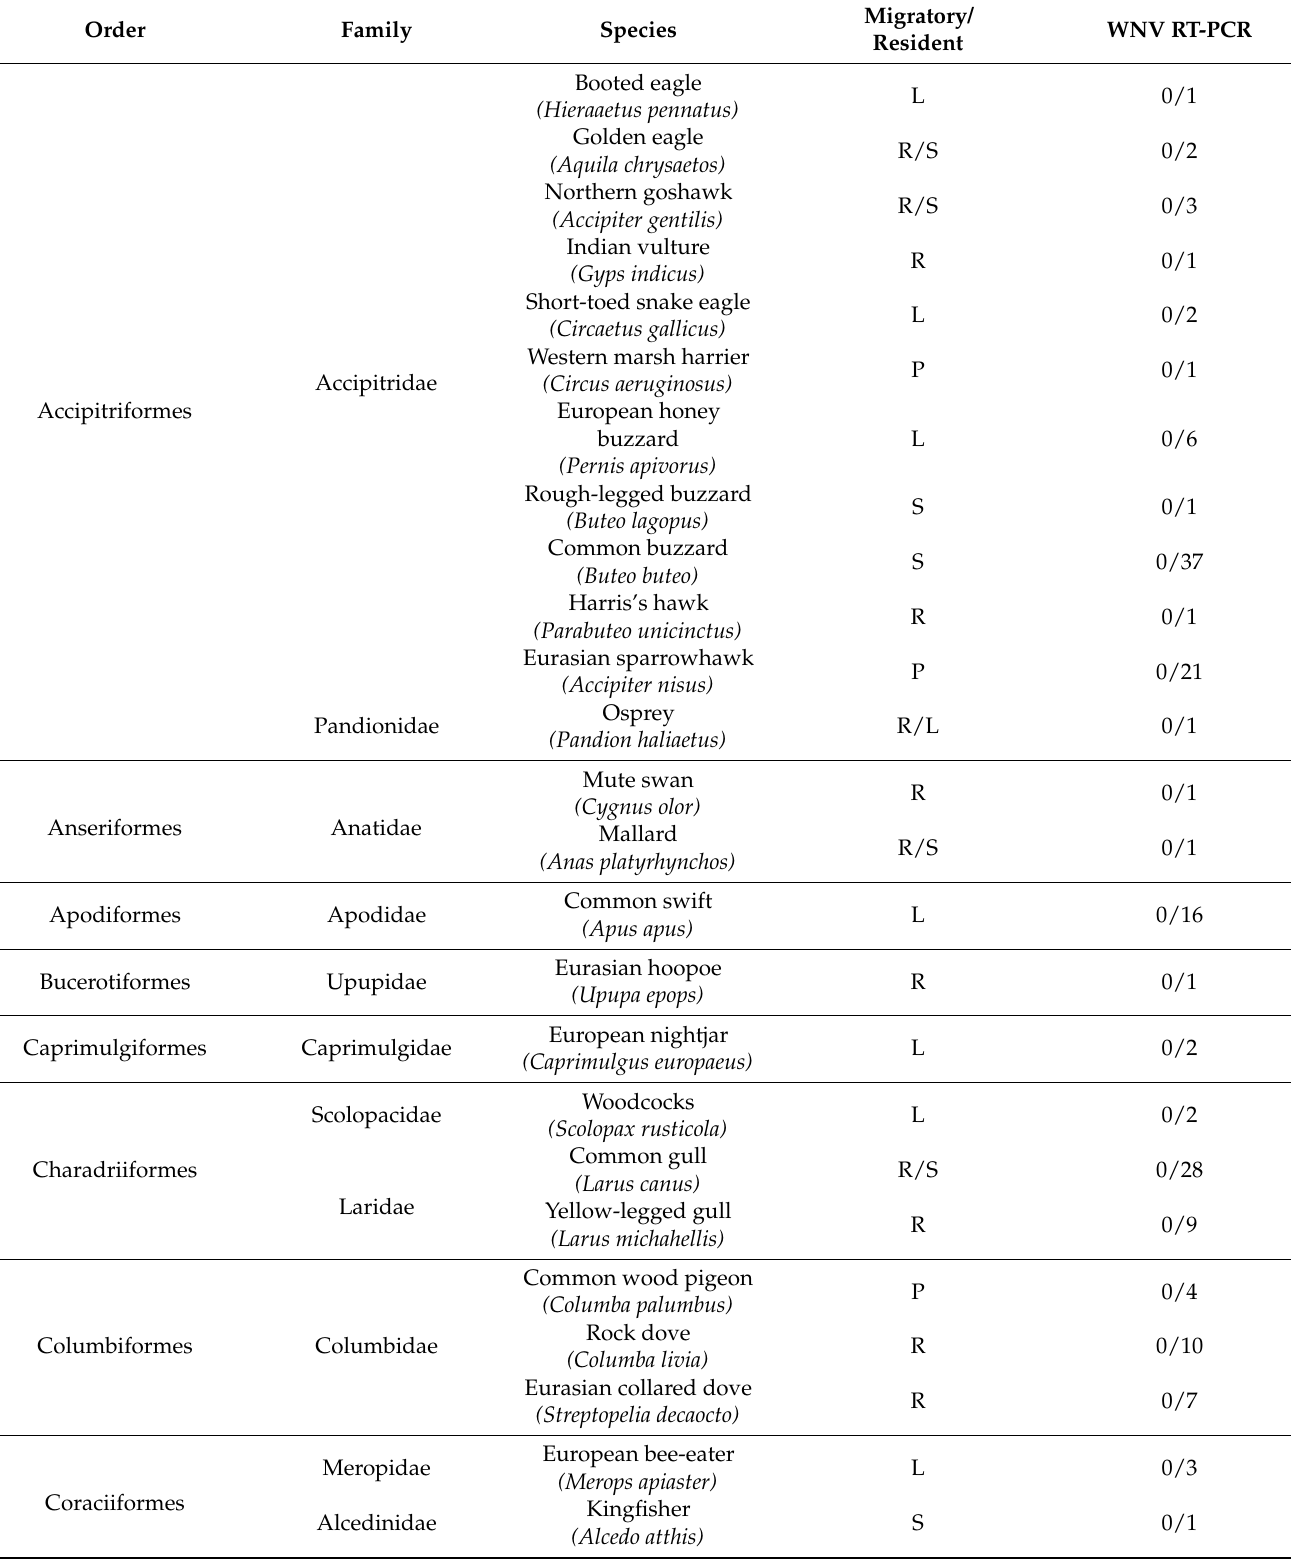
Table 1. Summary of examined avian species, migratory behavior and WNV RT-PCR results. Data on USUV RT-PCR are not included as results were negative for all the